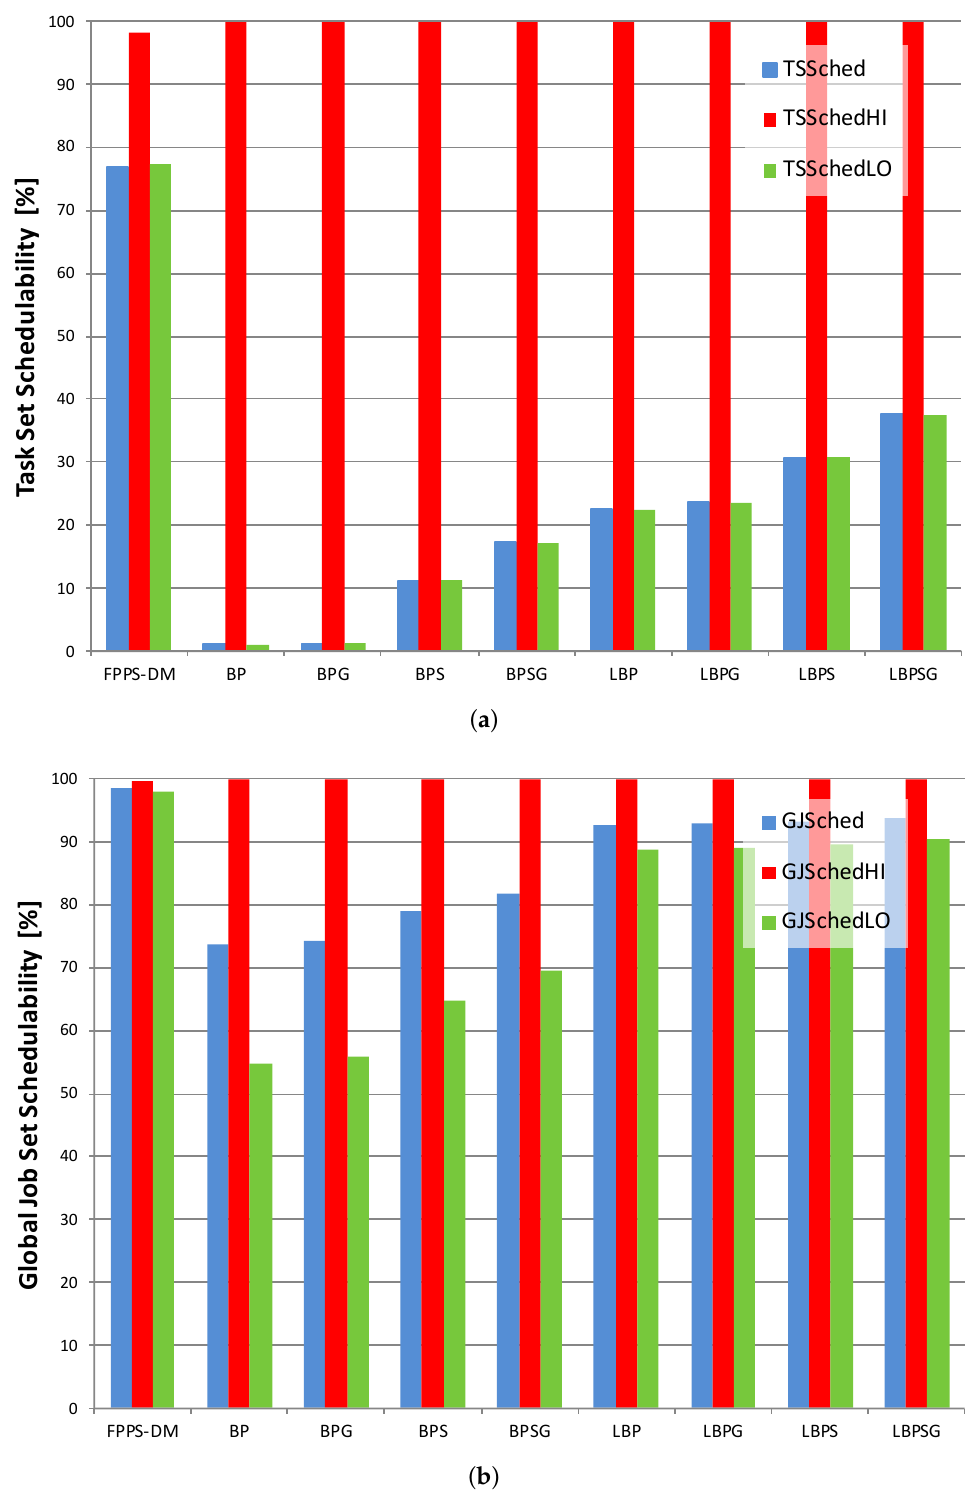
Figure 8. BP and LBP variants: schedulability in HC-MP scenario: ( a ) task sets with no jobs missed; and ( b ) average of jobs scheduled per task